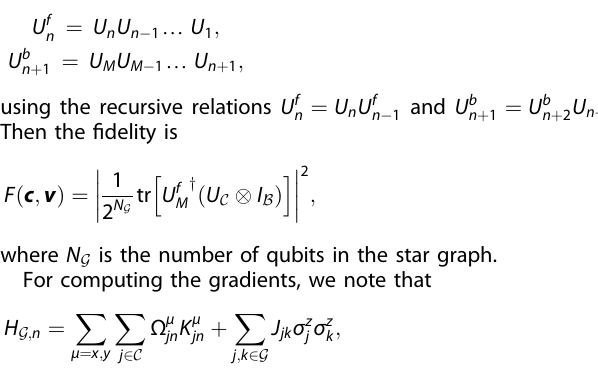
Table 1. robust optimisation improves the fi delities by two to three nines when the uncertanties are signi fi cantly large (1% and